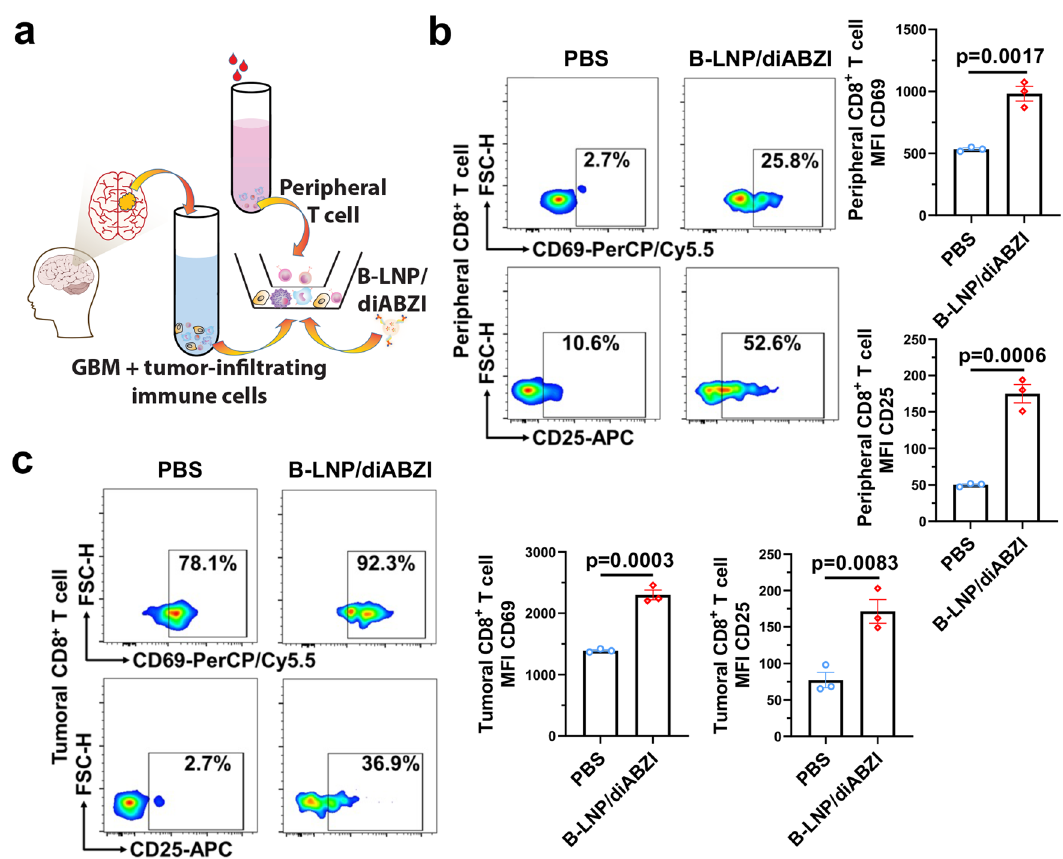
Fig. 7 | Anti-human CD47/PD-L1 functionalized B-LNP/diABZI activates GBM patient-derived T cells. a Schematic representation of ex vivo experiments using clinical specimens from GBM patients. The scheme was generated using Adobe Illustrator. The human brain illustration was sourced and adapted from Scidraw.io (doi.org/10.5281/zenodo.3925925, doi.org/10.5281/zenodo.3926065). Ex vivo sam- plesweretreatedwithPBSoranti-humanCD47/PD-L1functionalizedB-LNP/diABZI